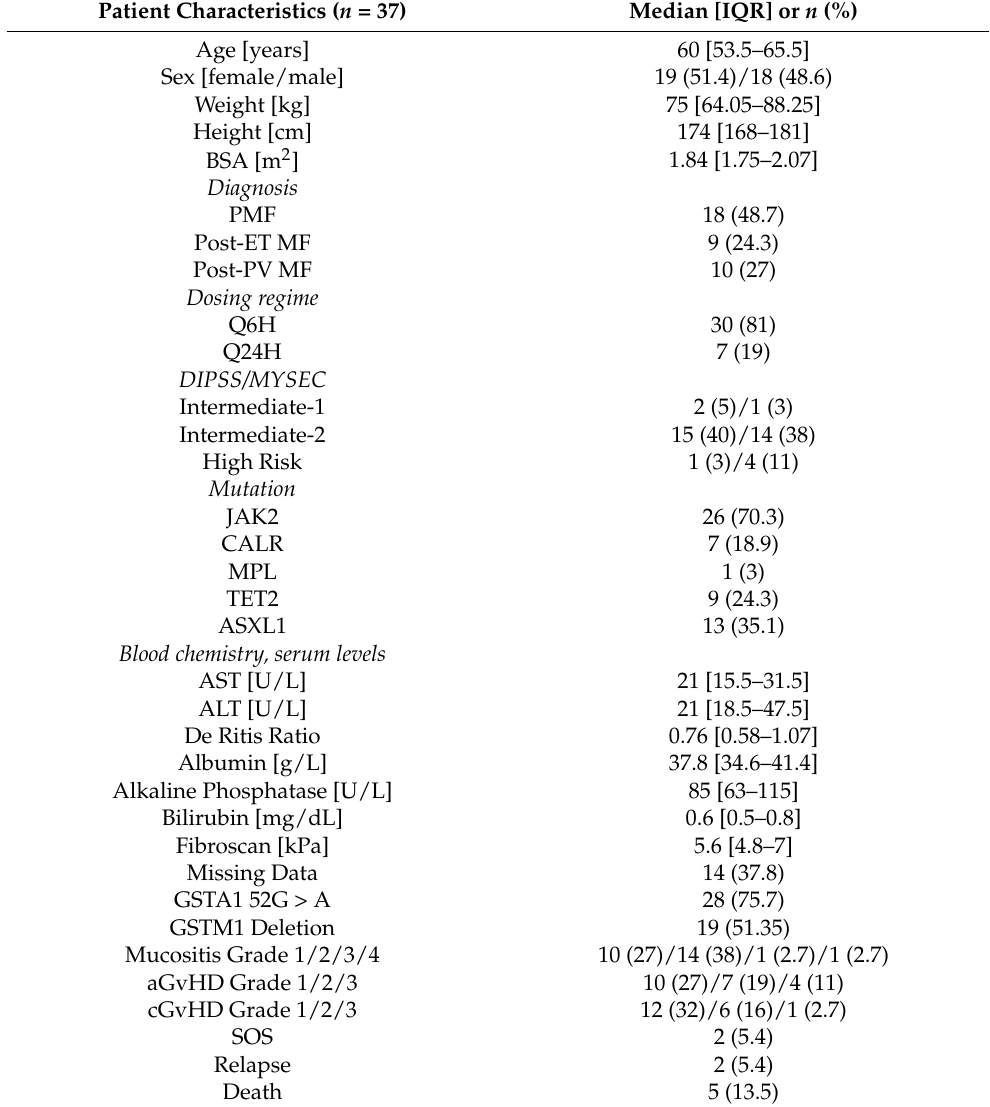
Table 1. Patient demographic and clinical